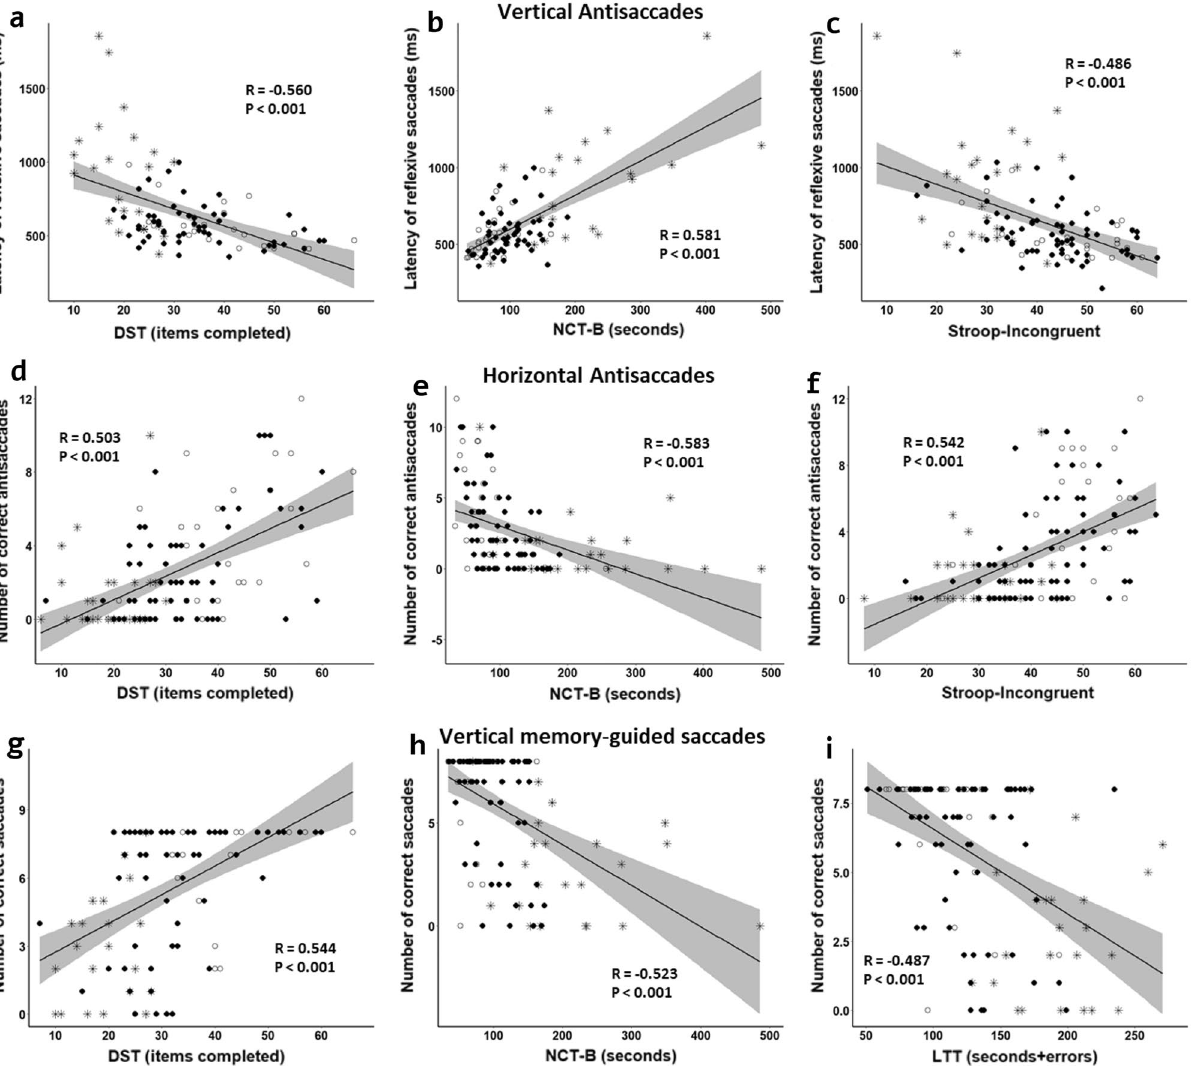
Figure 2. Correlations between eye movement tests and cognitive performance. ( a – c ) Correlations of Latency of reflexive saccades in vertical antisaccades test with subtests from PHES and Stroop test. ( d – f ) Correlations of correct antisaccades in horizontal antisaccades test with subtests from PHES and Stroop test. ( g – i ) Correlations of correct saccades in vertical memory-guided saccades test with subtests from PHES. Spearman correlation parameters (R and P) are shown. DST, Digit Symbol Test; NCT-B: Number Connection Test B; SD, LTT, Line Tracing Test. Each study group is indicated with different symbols: white circles (controls), black circles (NMHE patients) and stars (MHE